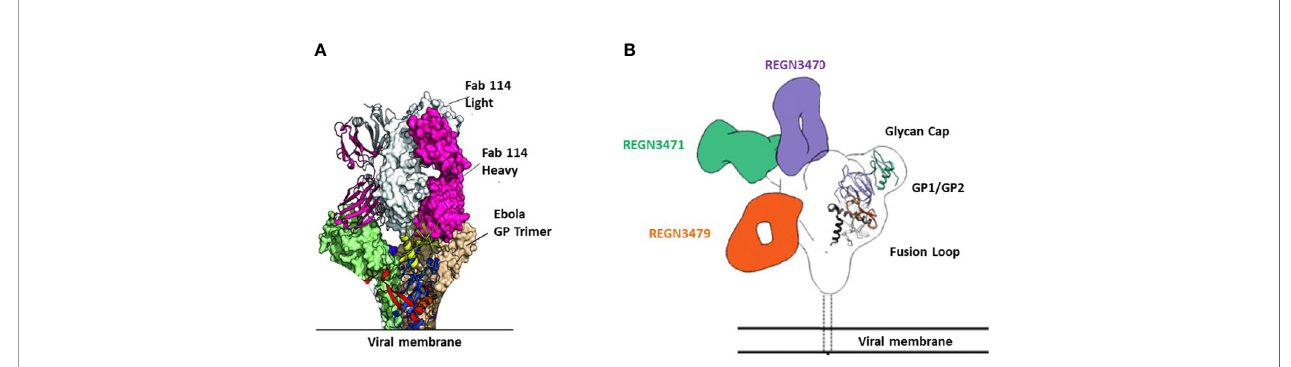
FIGURE 2 | Binding sites of FDA-approved mAbs therapeutics on EBOV GP. (A) Crystal structure of GP Muc interacting with Fabs of mAb114. Fabs are shown in pink (heavy chain) and white (light chain). GP Muc promoters are in green and beige for molecular surfaces while the third is represented by ribbon strings. (B) Relative binding sites of REGN-EB3 on EBOV GP. adapted from ref (20). REGN3471, REGN3470, and REGN3479 combined reconstructions on a single EBOV GP D TM, demonstrating the relative locations of the epitopes on GP from the three competition groups. Only one Fab is shown per